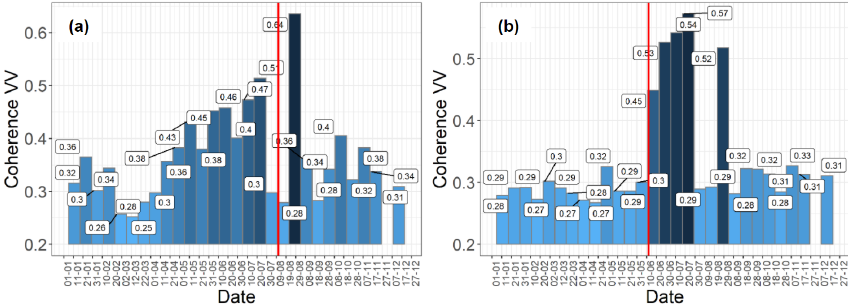
Figure 6. Coherence time series: ( a ) type 1, harvest (red line): 11 August 2018; ( b ) type 2, harvest (red line): 12 June